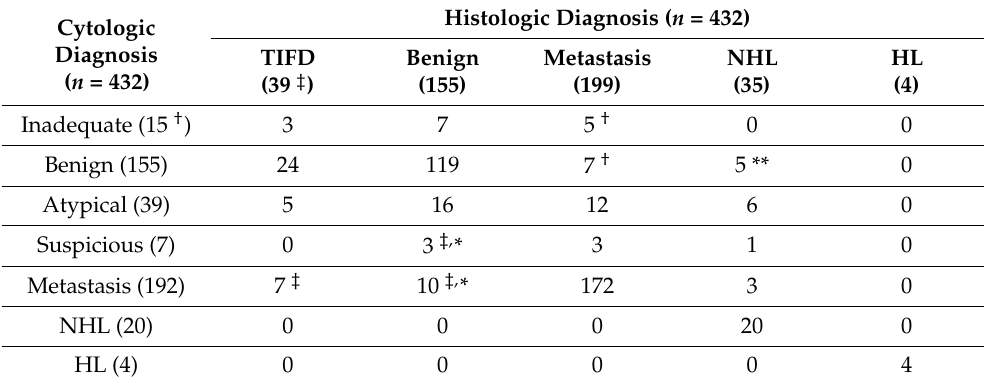
Table 2. Comparison of initial cytologic and histologic